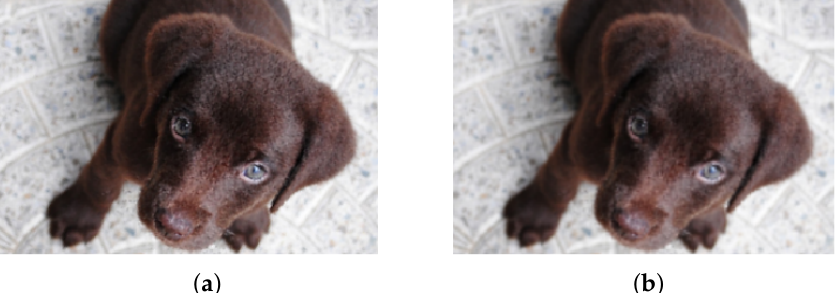
Figure 11. A rotation and a zoom apply to an image with one interpolation only ( a ) or two interpolations ( b ). The latter results in more texture